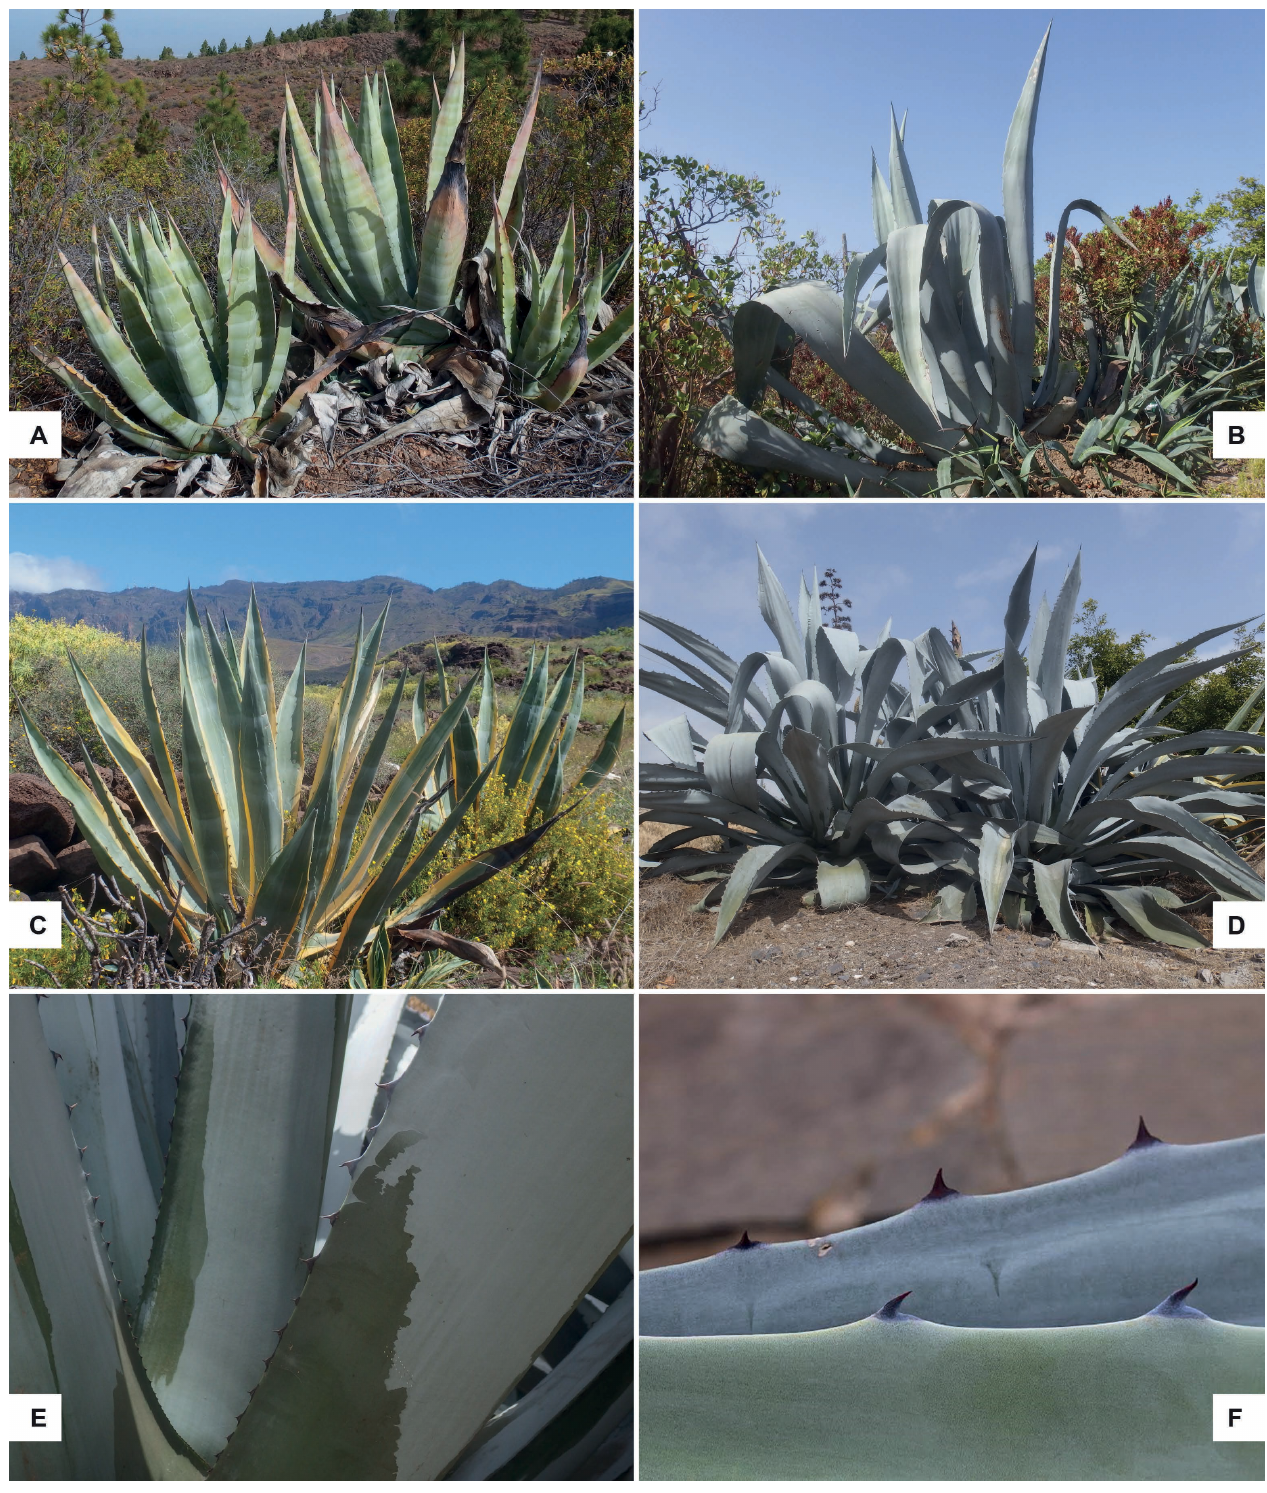
Figure 1 – A . Agave americana , Adeje, Taucho (T), July 2016. This is a very variable species in the study area. This form looks like but is not identical with var. expansa . It is a relatively small plant with shorter leaves that are held stiffly upright. B . Idem, Santa Brigida (C), April 2018. Another expression of the same species is massive with very large, rather pliable leaves. This form is reminiscent of A. franzosinii . C . Idem. Var. marginata , Santa Lucía de Tirajana (C), April 2018. D . A. franzosinii , Las Palmas de Gran Canaria (Tamaraceite) (C), April 2018. E . Idem. The glaucous covering of the leaves is easily rubbed off. F . Idem. Comparison of leaf colour and spine orientation in A. franzosinii (upper) and A. americana . Photographs: A–E by F. Verloove; F by M. Salas